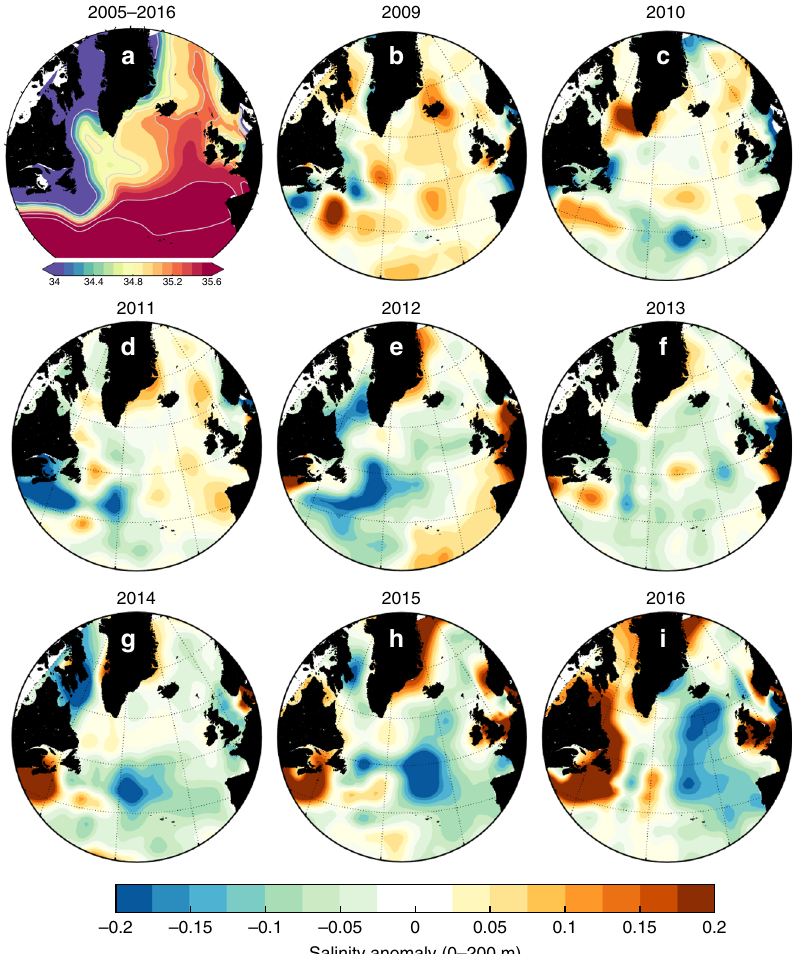
Fig. 2 The mean salinity of the shallow upper ocean in the subpolar North Atlantic, and the evolution of anomalies between 2009 and 2016. a mean salinity in the 0 – 200 m depth zone for the period of 2005 – 2016, computed from the EN4 dataset. b – i salinity anomalies of the 0 – 200 m layer in each year from 2009 to 2016, referenced to the 2005 – 2016 mean; warm colours represent higher salinity and cool colours are lower salinity. In 2012 a strong negative salinity anomaly developed in the Newfoundland Basin, and by 2016 it had propagated to the Iceland Basin and Rockall Trough. A strong positive anomaly developed in the North West Atlantic continental shelf and slope region during 2014 –